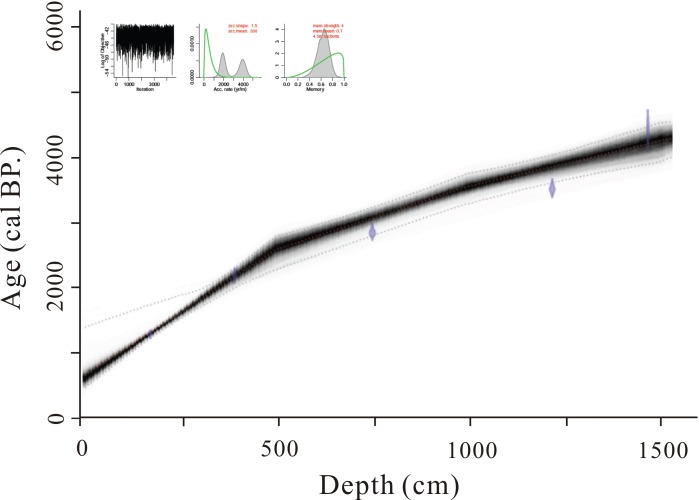
The Bayesian age-depth model of the Xiaozhongdian Basin section.